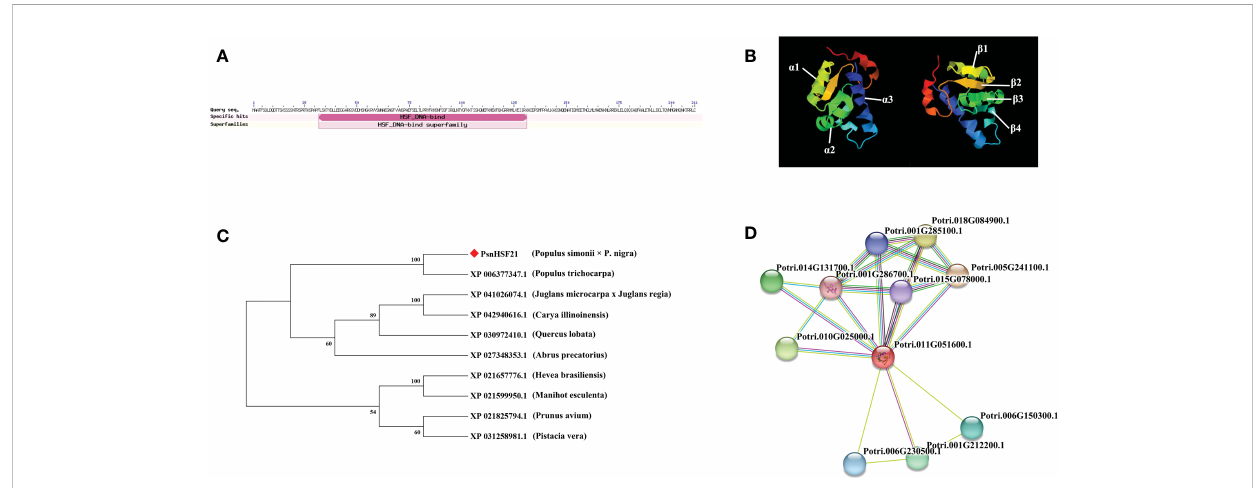
FIGURE 7 (A) Exhibition of the conserved domain of PsnHSF21 protein. (B) The schematic diagram of the tertiary structure of the PsnHSF21 protein. (C) Phylogenetic relationship between PsnHSF21 and HSFs in various species. (D) Prediction of PsnHSF21 interaction